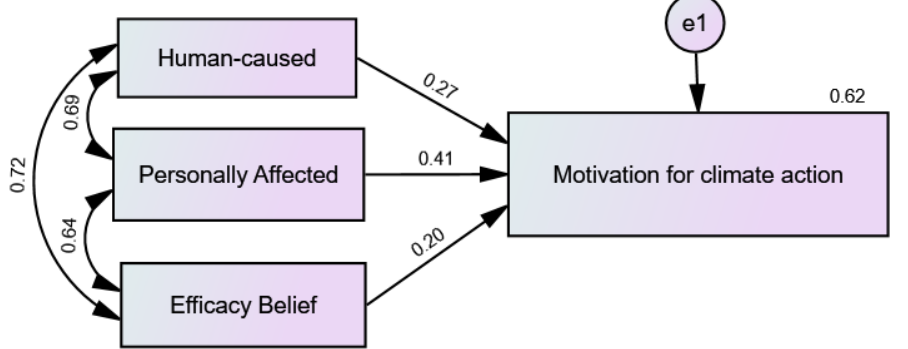
Figure 3. Impacts of Pre-intervention Climate Action Precursors on Pre-intervention Climate Action Motivation.